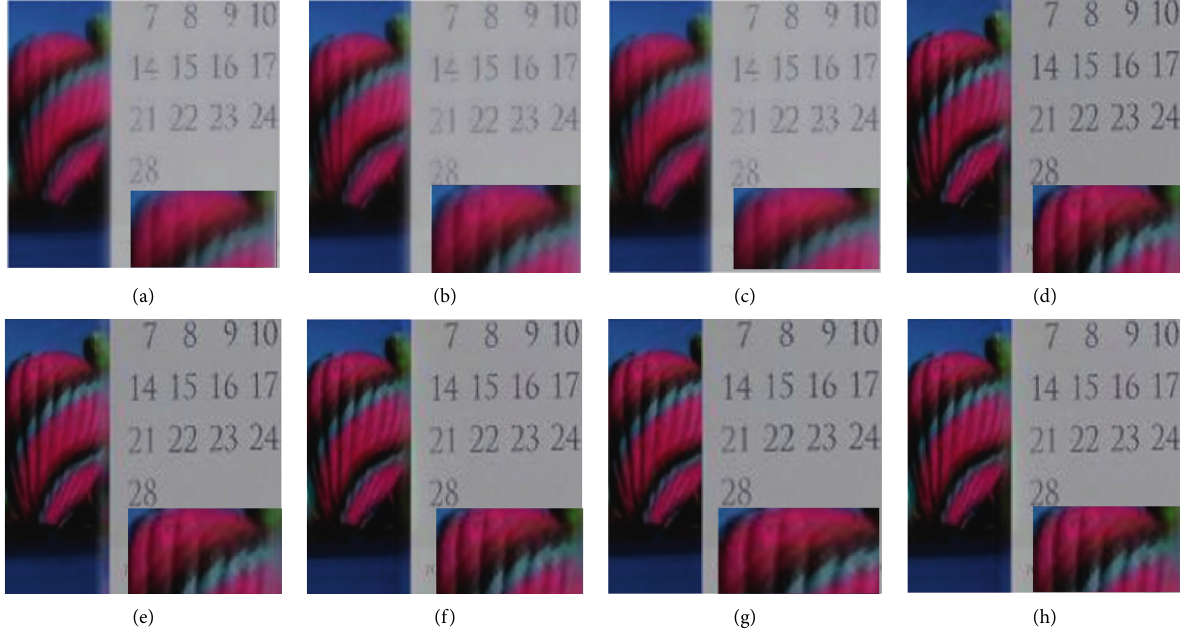
Figure 11: The fusion results of “Calendar.” (a) PCNN. (b) Contourlet. (c) GAN. (d) Shearlet. (e) CSR. (f) SR-SML. (g) DCNN. (h) Proposed.